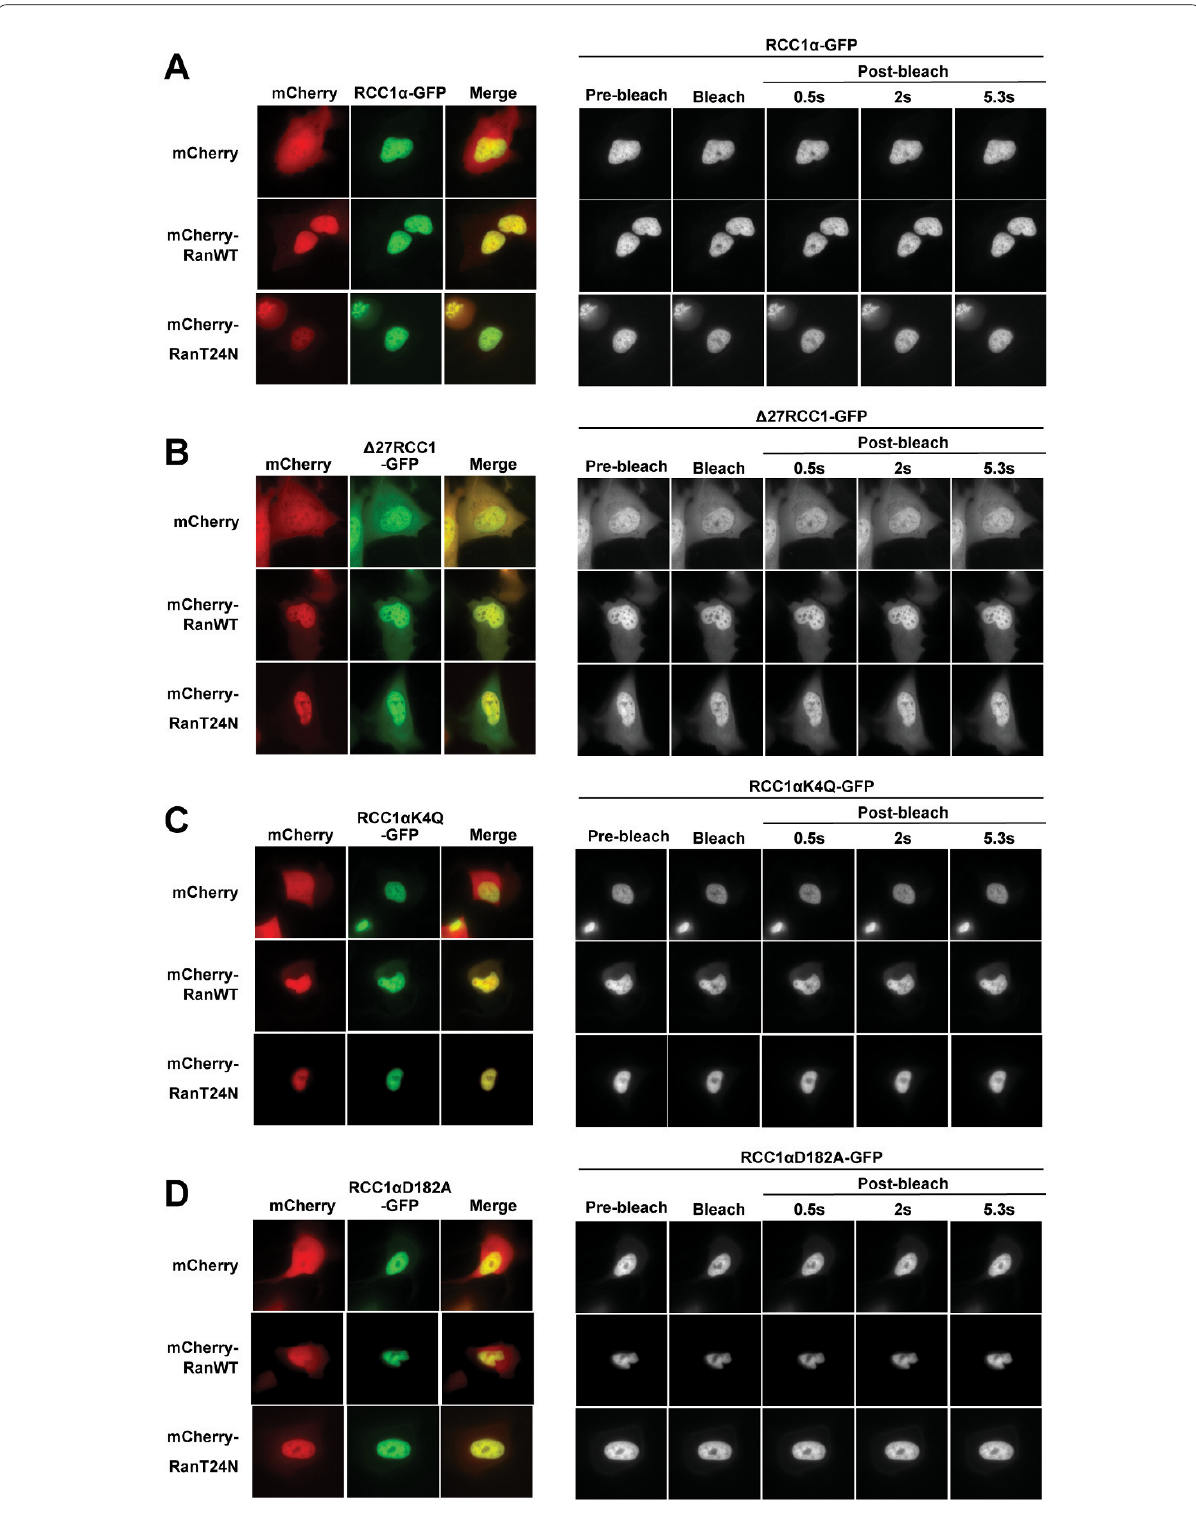
Figure 2 Effect of Ran on the interaction of RCC1α with chromatin in live cells . Representative images of live U2OS cells co-expressing wild-type Ran T24N (bottom) during fluorescence recovery after photobleaching